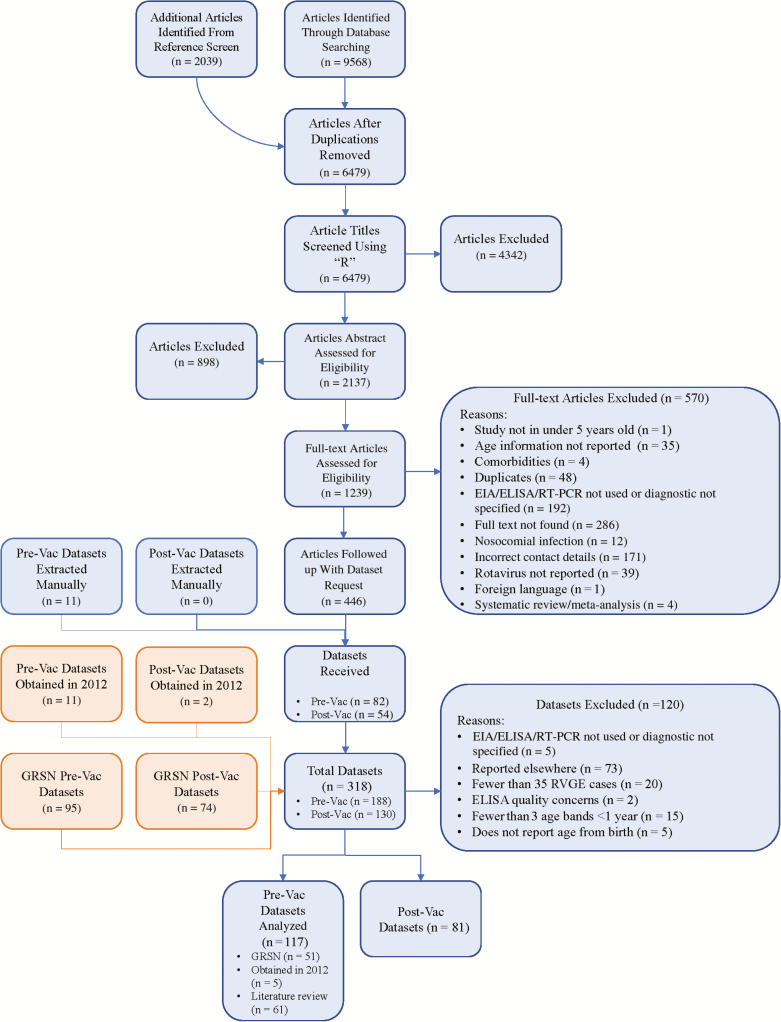
Flowchart of the study selection process and data extraction. Some studies contained multiple datasets. Abbreviations: EIA, enzyme immunoassay; ELISA, enzyme-linked immunosorbent assay; GRSN, Global Rotavirus Surveillance Network; Pre-Vac, prevaccination; Post-Vac, postvaccination; RT-PCR, reverse-transcription polymerase chain reaction.